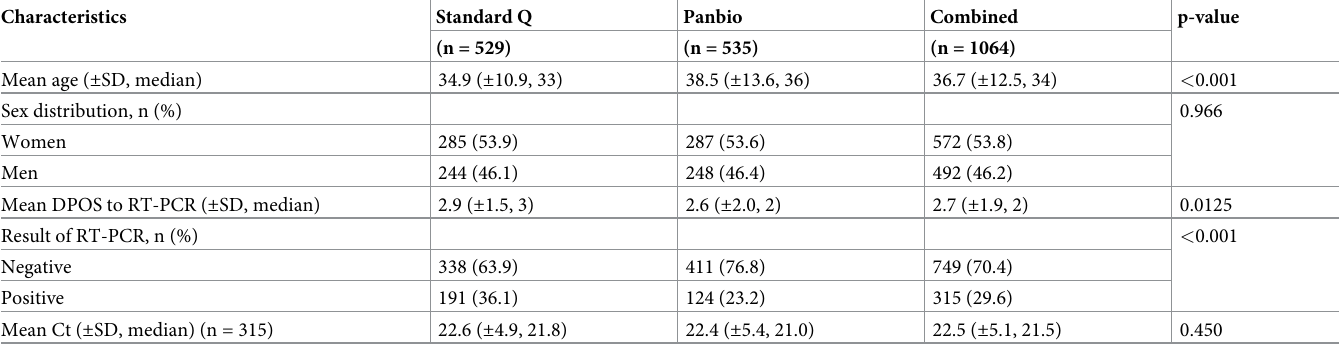
Table 1. Characteristics of the study population.